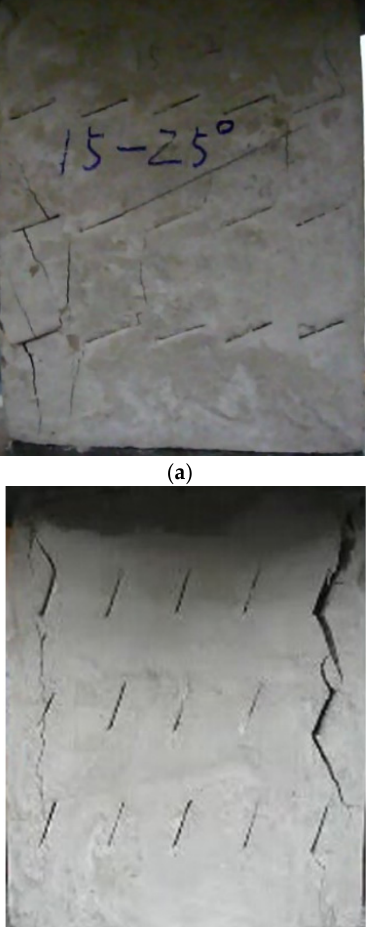
Figure 7. The failure process with 10 cracks. ( a ) 25°; ( b ) 45°; ( c ) 75°; ( d ) 90°.